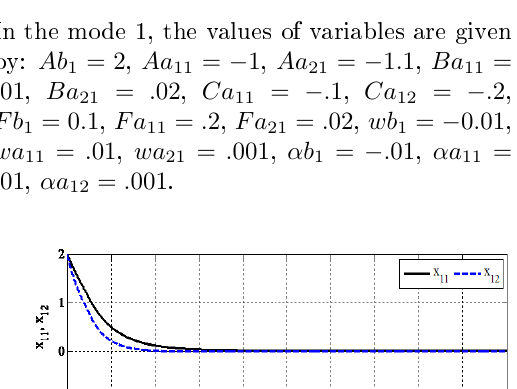
. 02 , αa 22 = . 05 and the membership